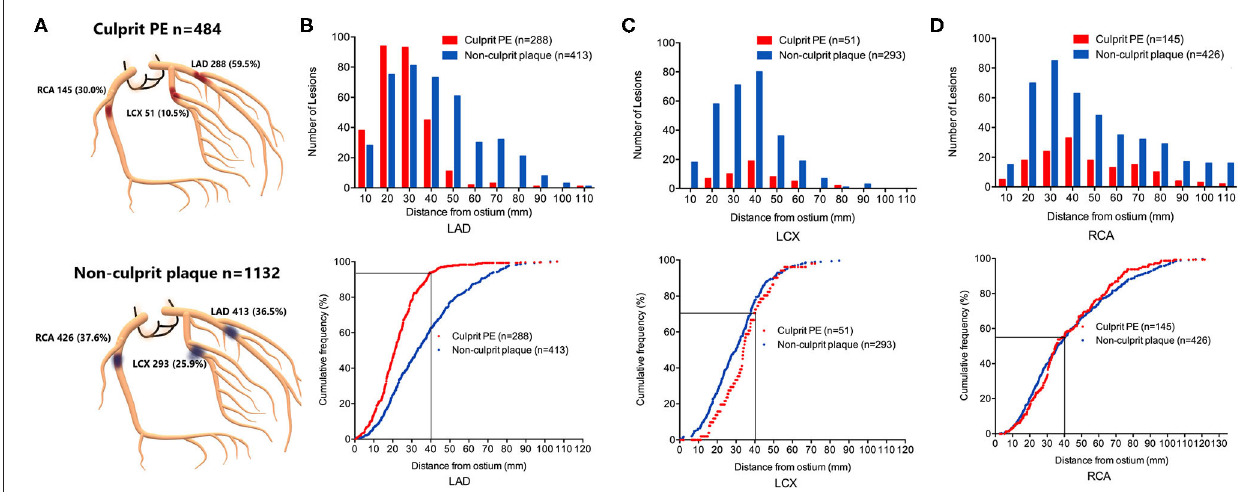
FIGURE 1 | Location and longitudinal distribution of culprit PE and non-culprit plaques in STEMI patients with culprit plaque erosion. (A) Culprit PE in STEMI patients were mainly in the LAD, followed by RCA and LCX. Non-culprit plaques were evenly distributed in the RCA and LAD, followed by the LCX. The number of lesions and cumulative frequency of culprit PE and non-culprit plaques every 10mm axial distance from the ostium of the LAD (B) , LCX (C) , and RCA (D) were shown. 93.8% of culprit eroded plaques in the LAD were within the proximal 40mm of the artery. Among all plaques (culprit and non-culprit) within the proximal 40mm of the LAD, over half represented culprit plaque erosions that were responsible for the acute event. LAD, left anterior descending artery; LCX, left circumflex artery; PE, plaque erosion; RCA, right coronary artery.